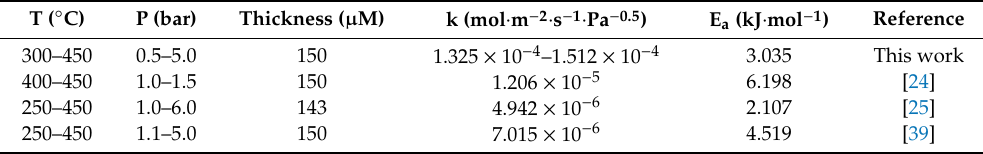
Table 1. Main parameters obtained from permeation tests for PdAg self-supported